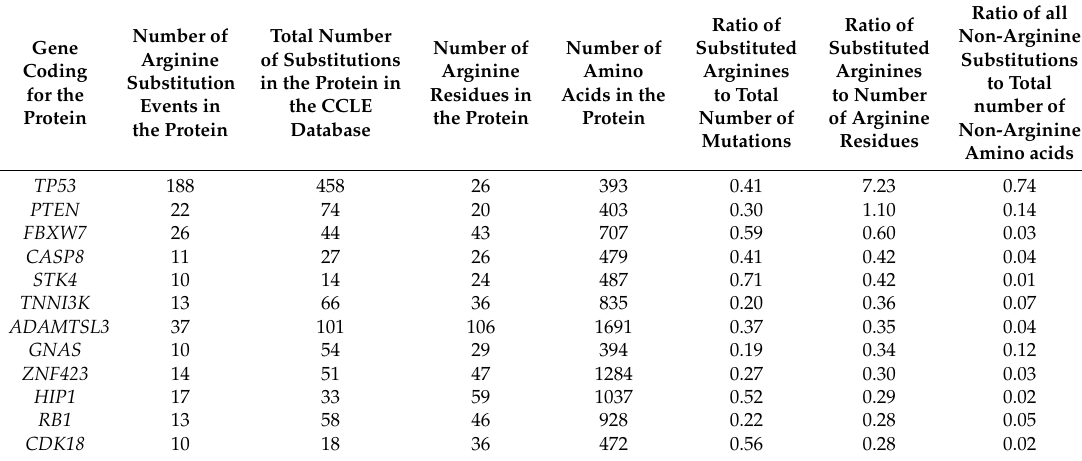
Table 1. Proteins with the highest ratio of events of substitutions of arginine in the CCLE database to the total number of arginine residues in the protein